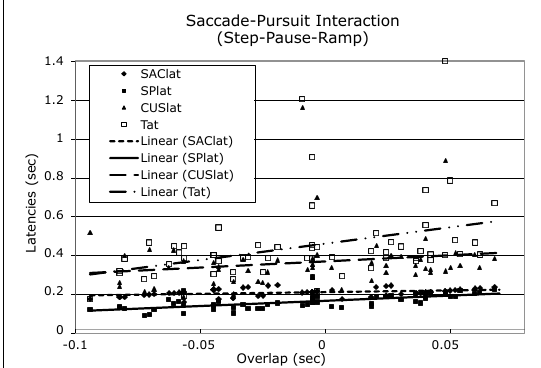
Figure 9. Plots of SAClat, SPlat, CUSlat, Tat vs. Overlap for S1 (representative of data from all subjects) with linear fits to each data set. CUSlat = catch-up saccade latency; Tat = target acquisition time (t T R 0 ); Overlap = t s - R 0 . See Methods for definitions of these